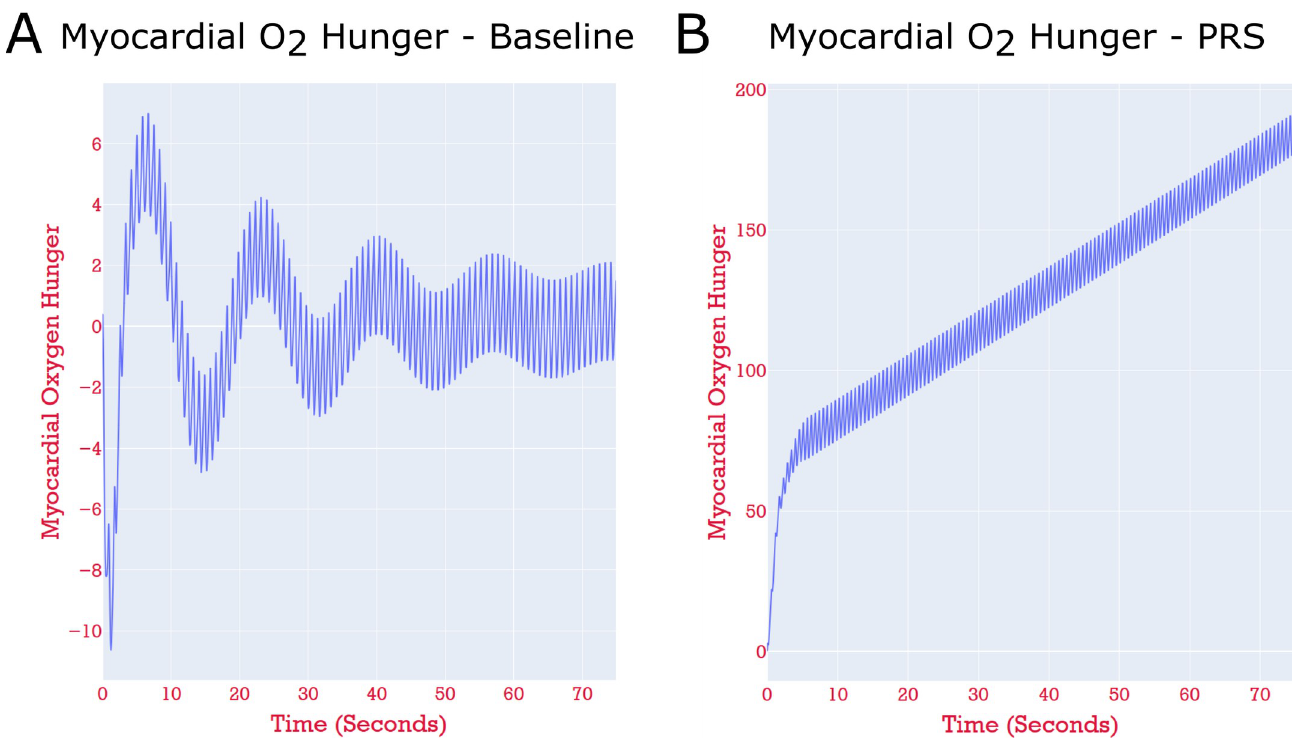
Fig 6. The results of running a pure zero-dimensional simulation of the model shown in Fig 5. Note the differing y-axis scales. Panel A: Case C1—the time evolution of the myocardial hunger in the left anterior descending (LAD) perfusion territory of the myocardium, in the patient-specific simulation under baseline resting conditions. The blood supply is such that the hunger is kept close to zero for the entire simulation. Panel B: Case C2—the model with parameters perturbed to simulate PRS. The hunger grows continually, indicating that the blood supply to this perfusion territory is insufficient, and thus, myocardial ischaemia.